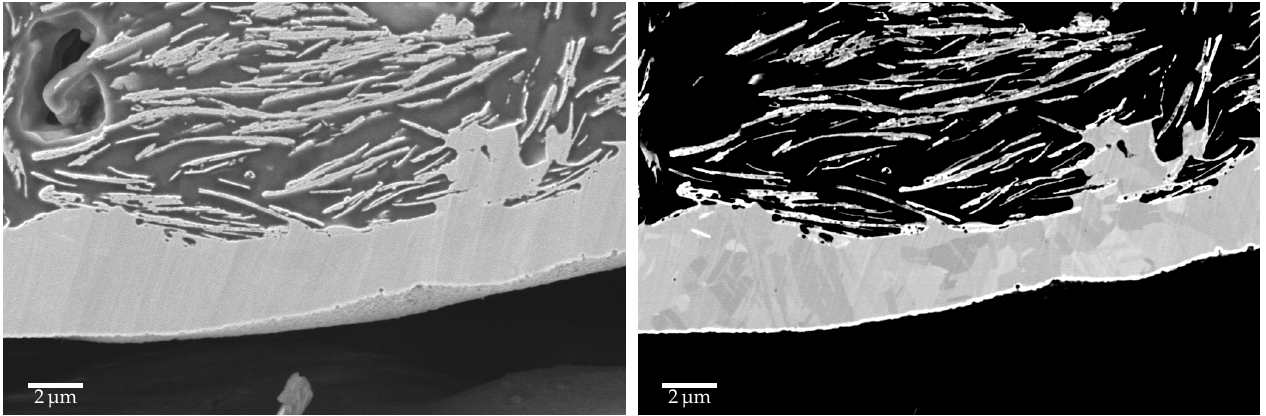
Figure 4. SEM images of the electroplated silicone electrode: particle-silicone composite with gas entrapment (top), metallic copper layer (center), embedding agent (epoxy resin, bottom).